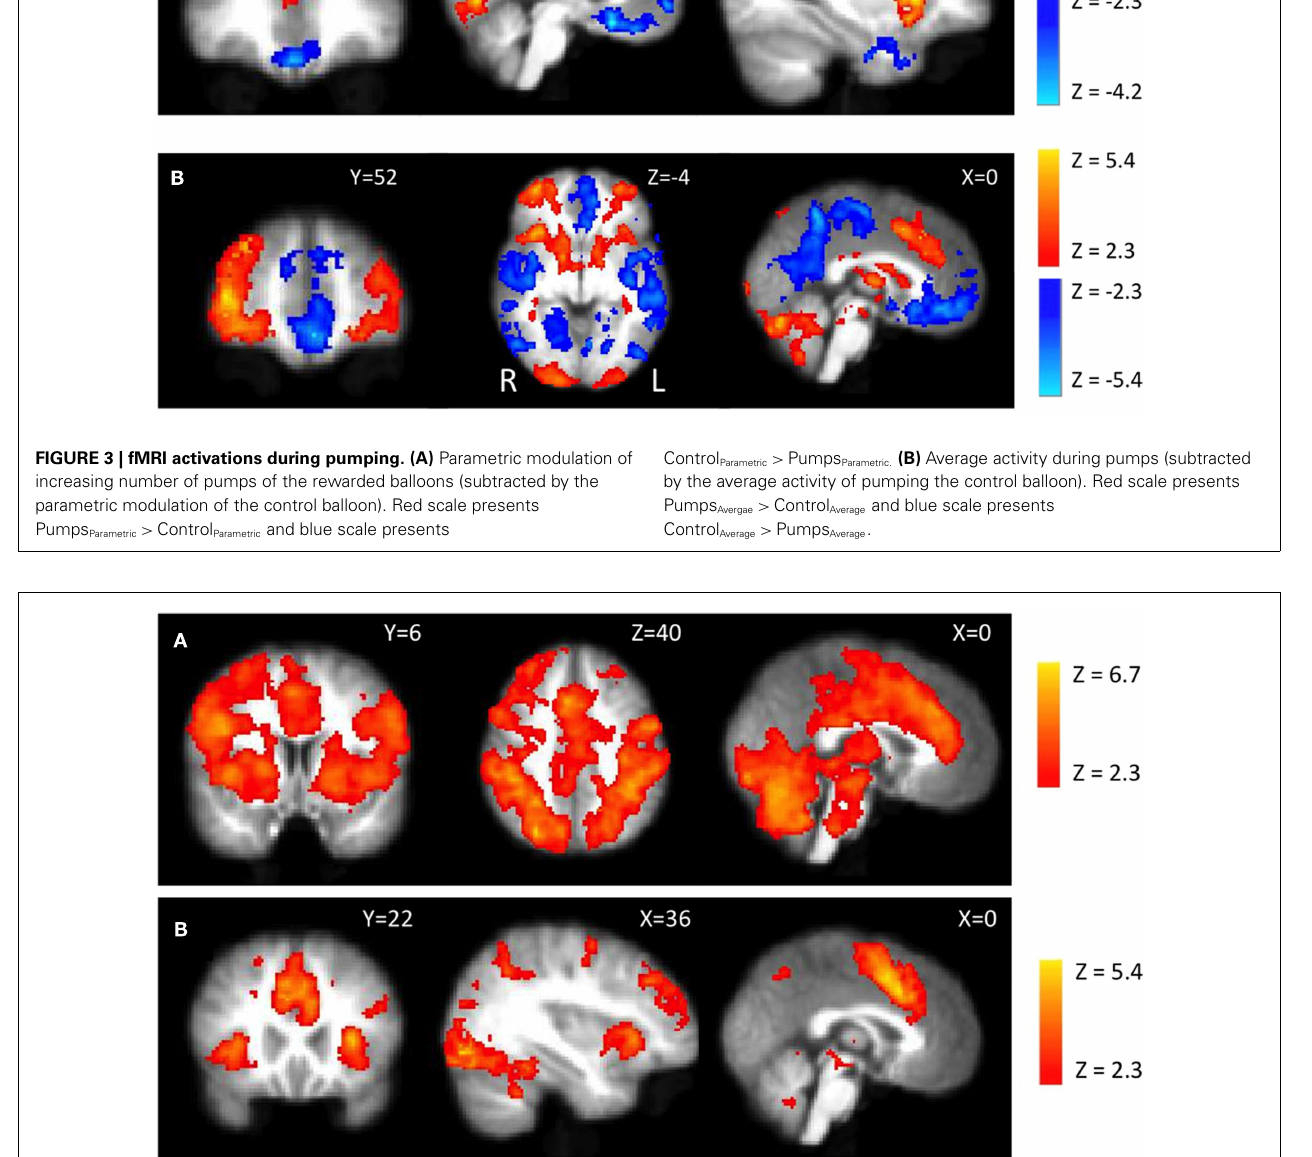
FIGURE 4 | fMRI activations during cash-outs. (A) Average activity during cash-out events. (B) Reaction time modulated activity during cash-out events.